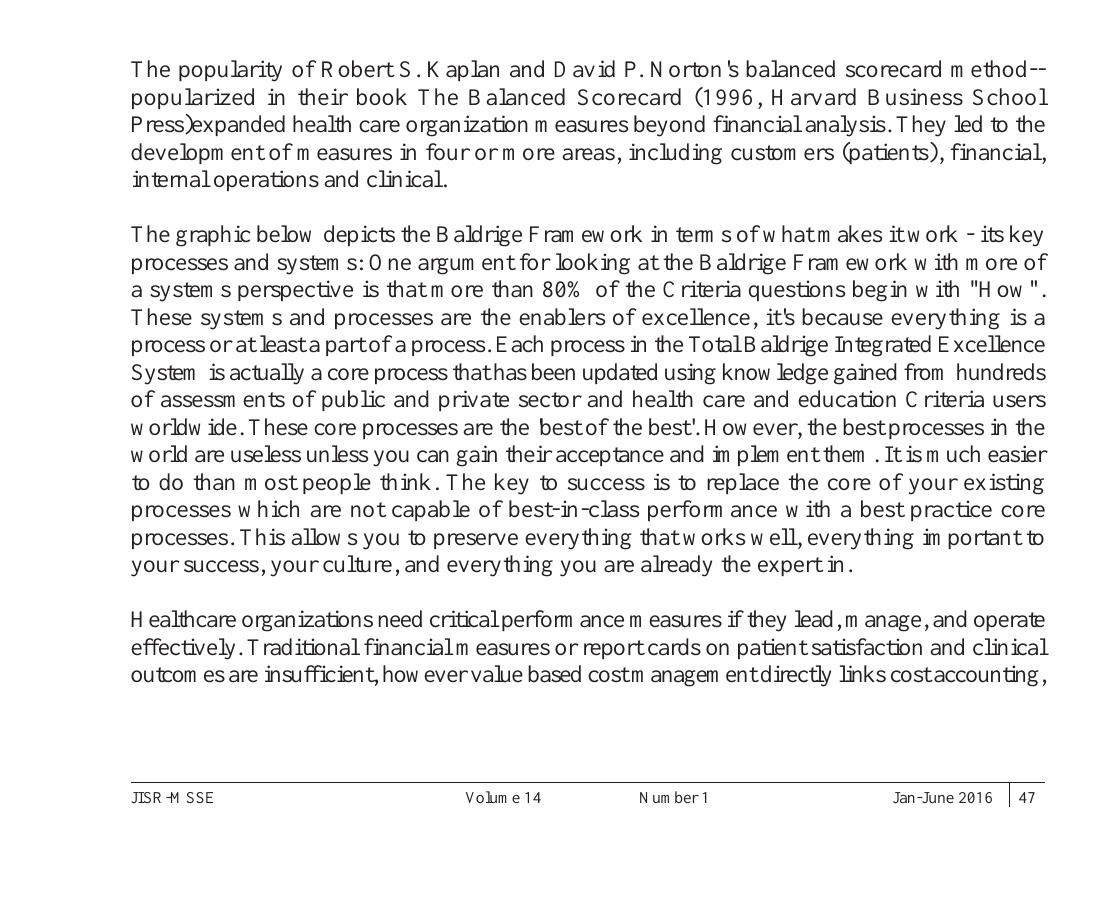
Self Assessment (Baldrige Criteria)